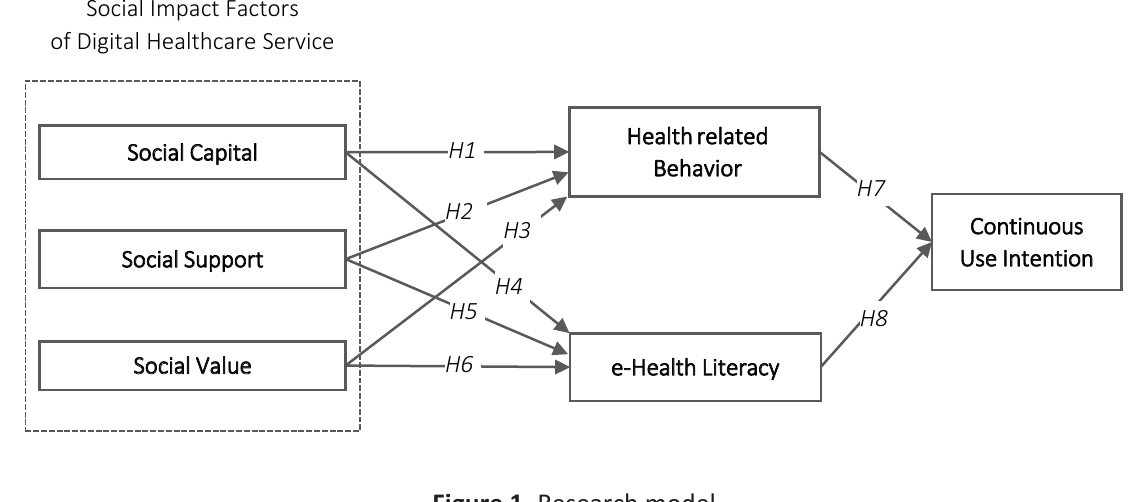
Figure 1. Research model